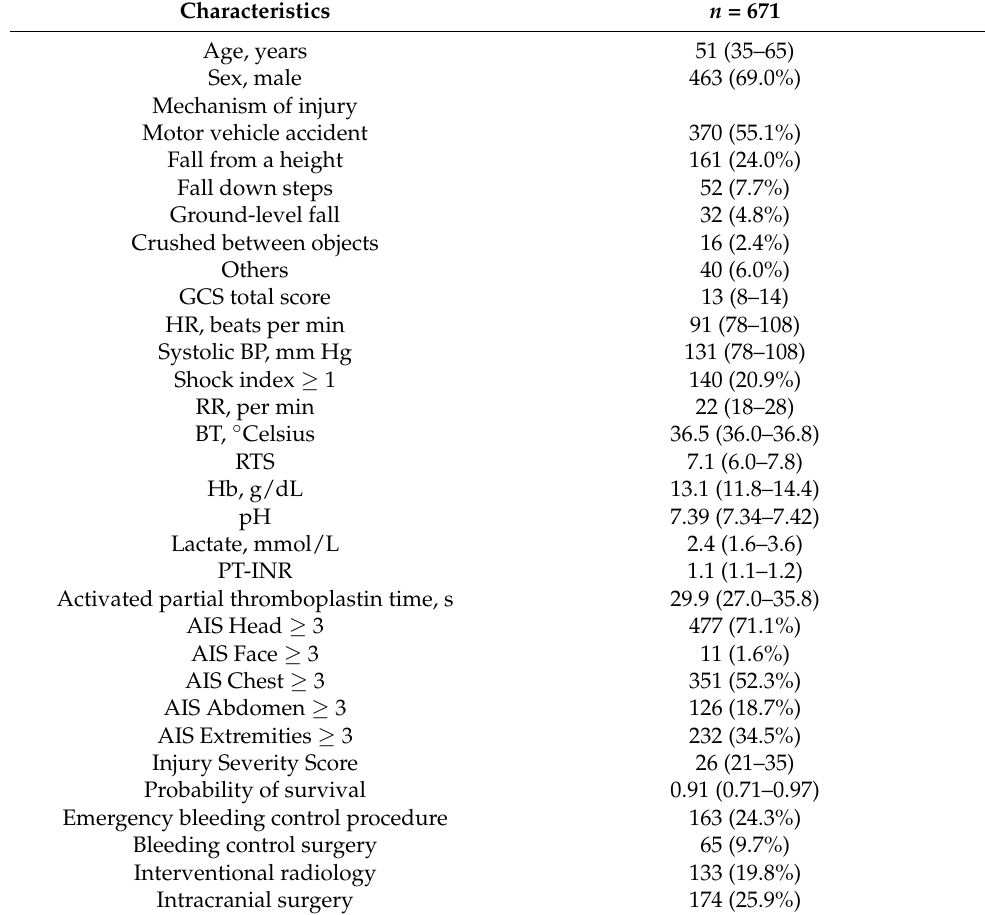
Table 1. Baseline characteristics and diagnostic data of the study